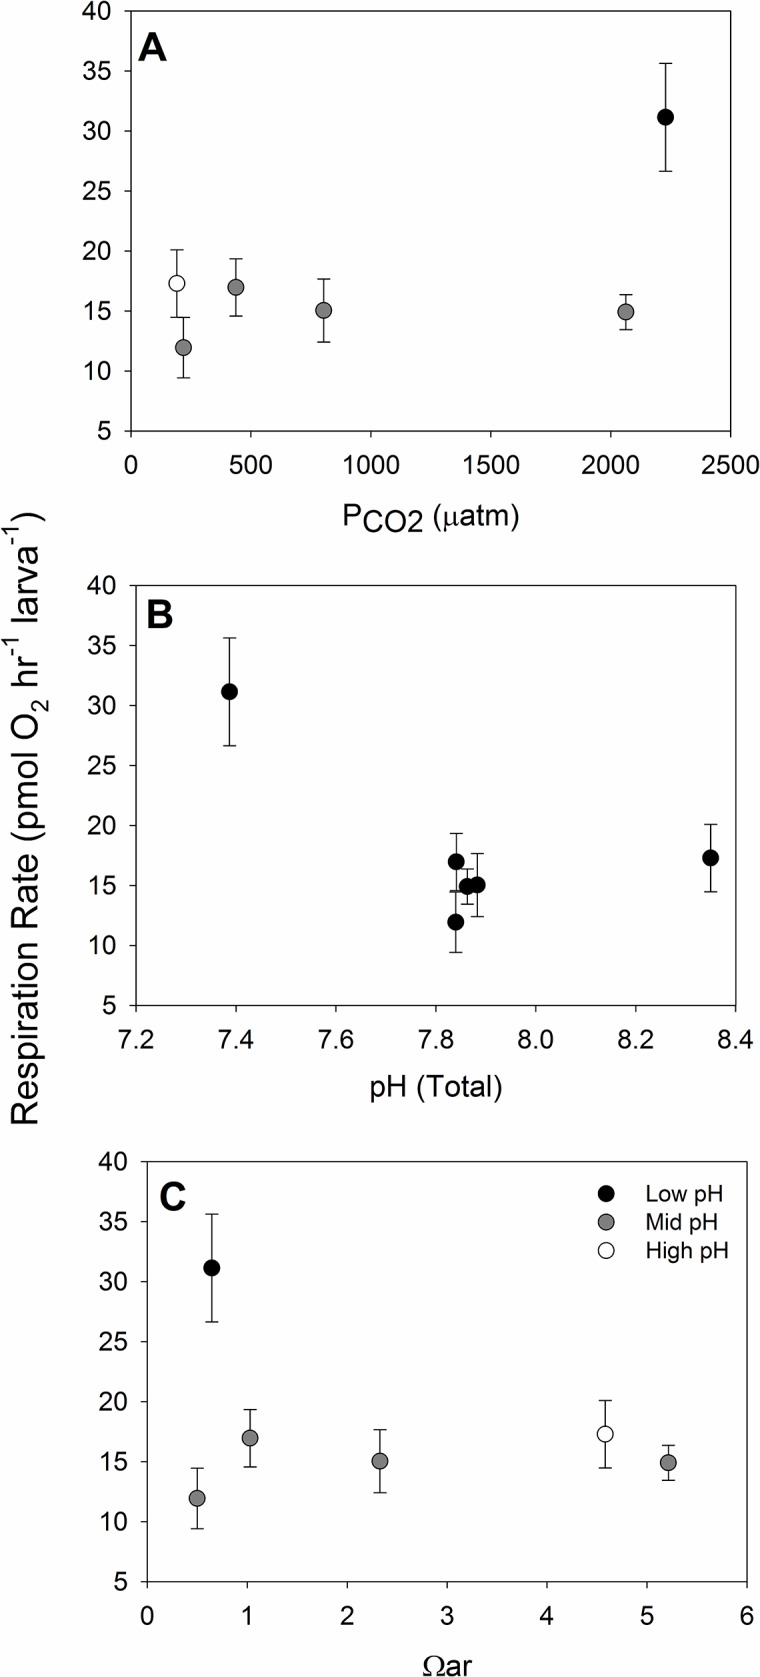
Larval Respiration.Respiration rate of larvae immediately following the 48 hour post-fertilization and experimental period in response to (A) PCO2, (B) pH, and (C) Ωaragonite. Error bars are standard deviations of the five replicate experimental chambers per treatment. The grayscale in this graph represents the three pH categories for the treatments used in the reduced experimental matrix (see Table 1).